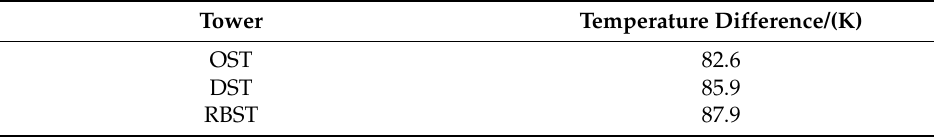
Table 5. Temperature difference between inlet and outlet.